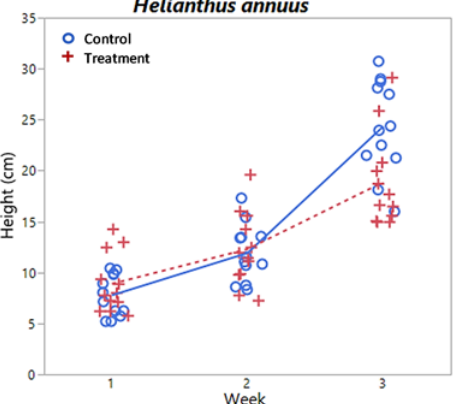
Figure 9 . Height by week and treatment level for H. annuus . Lines (solid = control, dashed = treatment) indicate mean values at each week.